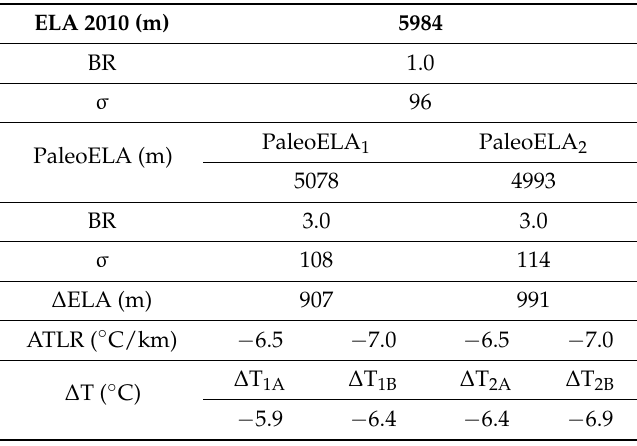
Table 5. ELA depression and climate cooling.